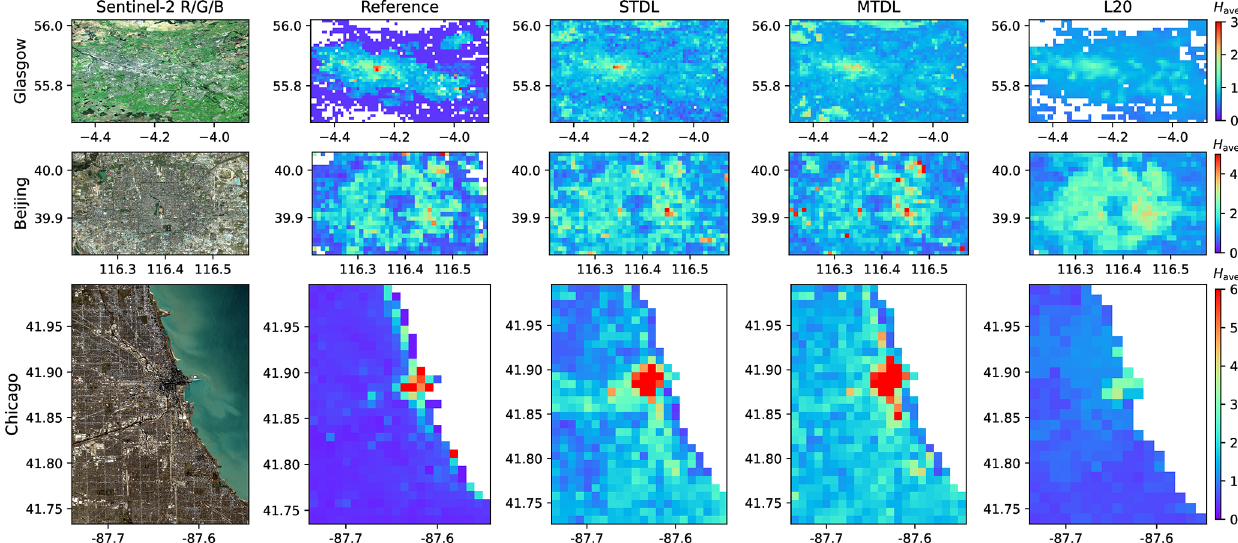
Figure 14. Building height close-ups in Glasgow, Beijing and